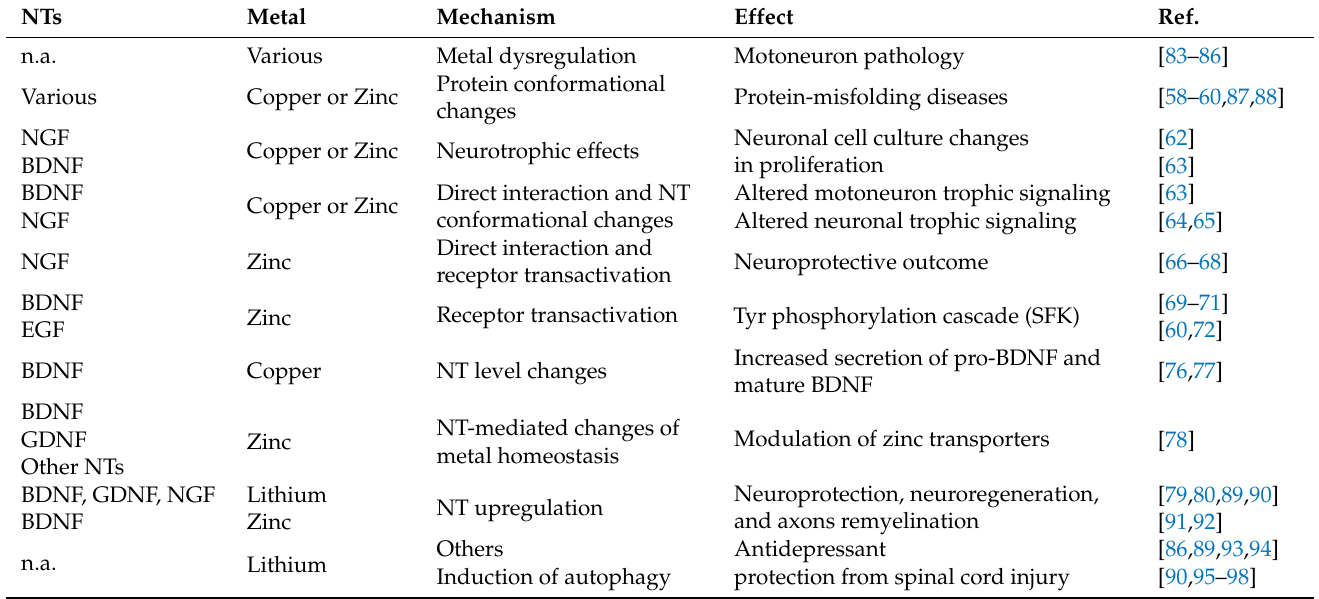
Table 1. Neurotrophin–metal interplay and metal-related neuromodulatory